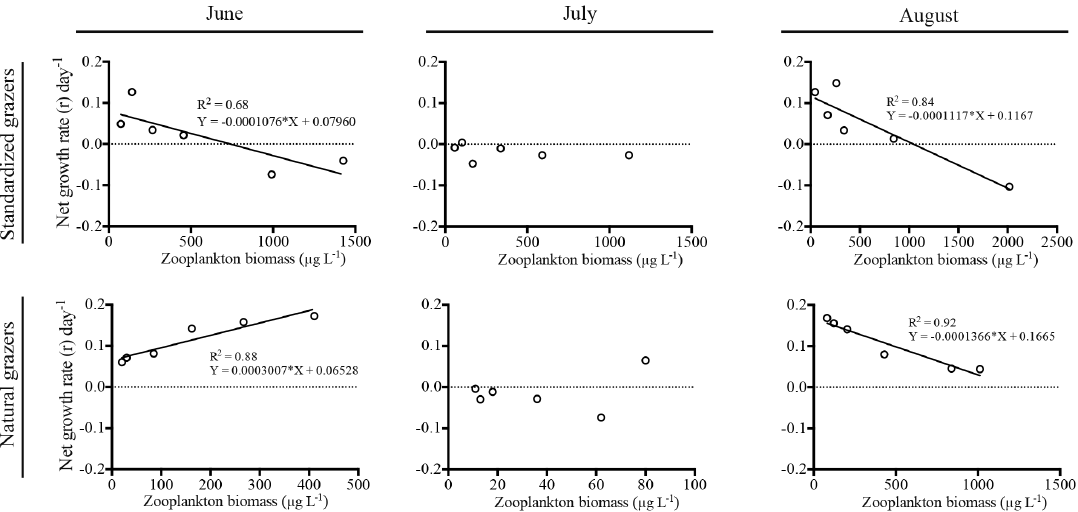
Figure 4. Net growth rates (r) of the cyanobacterial community during June, July and August in relation to grazer abundance. Top panel= Daphnia dominated community (standardized grazers) and Lower panel=natural zooplankton community. Regression lines show significant